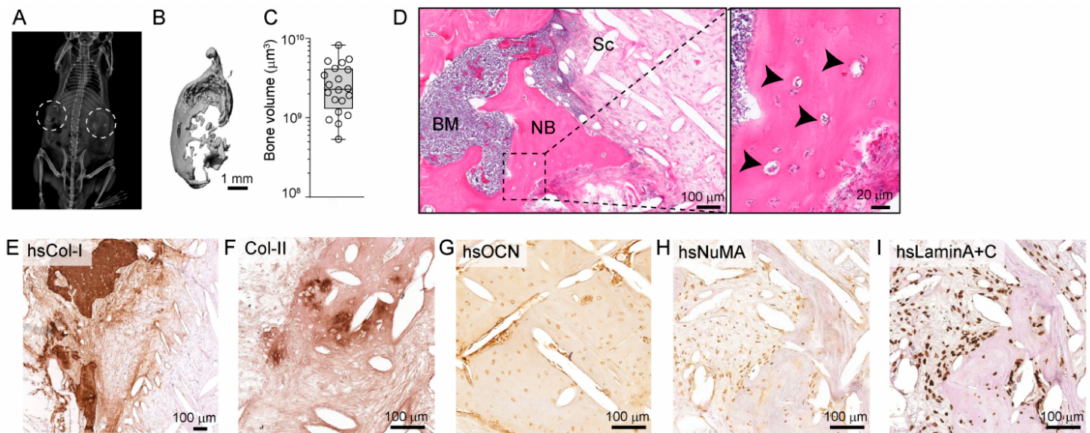
Figure 1. The humanized tissue-engineered bone construct (hTEBC) forms a physiologically representative organ bone in vivo. ( A ) X-ray imaging of the mice 4 weeks after scaffold implantation reveals calcified tissue formation (the dashed circles represent the hTEBC transplantation site). ( B ) Morphology of the hTEBC at the experimental endpoint, 10 weeks after hTEBC implantation and ( C ) quantitative analysis of bone volume from the hTEBC ex vivo using µ -CT analysis (n = 20 hTEBC; individual data points are represented within the box plot). ( D ) Hematoxylin and eosin (H&E) staining for morphological overview of the bone organ depicting bone marrow (BM), newly formed (NB), residual medical grade polycaprolactone (mPCL) scaffold fibers (Sc) and mature osteocytes embedded in the bone matrix (arrowheads). Immunohistochemical staining for ( E ) human-specific type-I collagen (hsCol-I), ( F ) type-II collagen (Col-II), ( G ) human-specific osteocalcin (hsOCN), ( H ) human-specific nuclear mitotic apparatus protein-1 (hsNuMA) and ( I ) human-specific Lamin A+C (hsLaminA+C). Scale bars represent 100 µ m and 20 µ